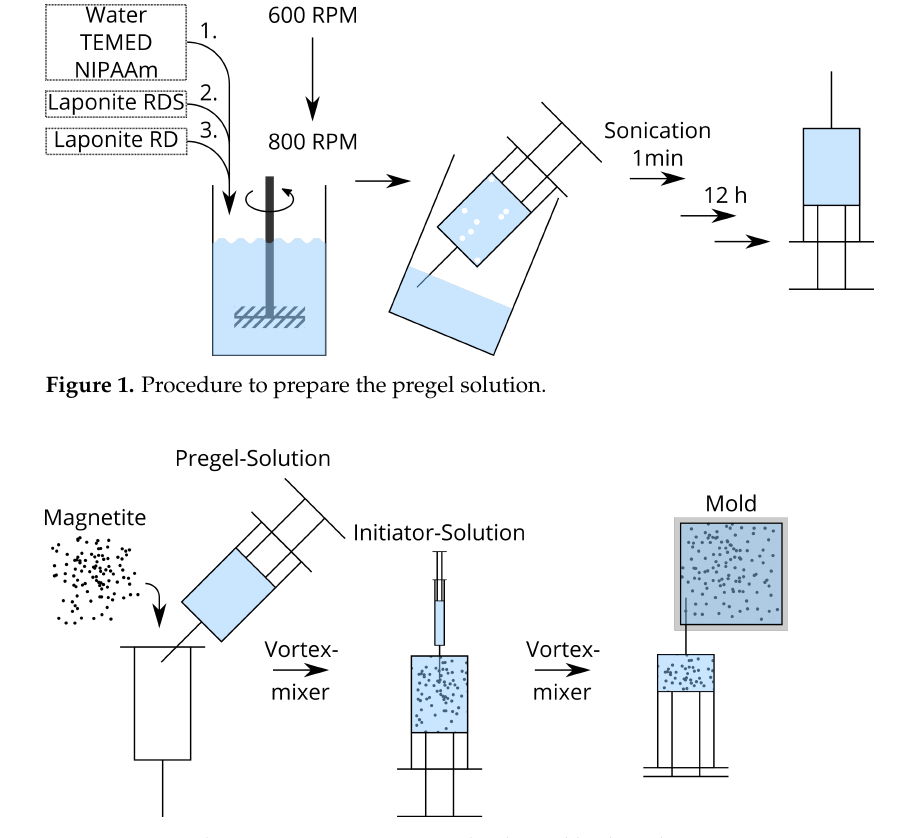
Figure 2. Procedure to prepare a magnetorheological hydrogel.